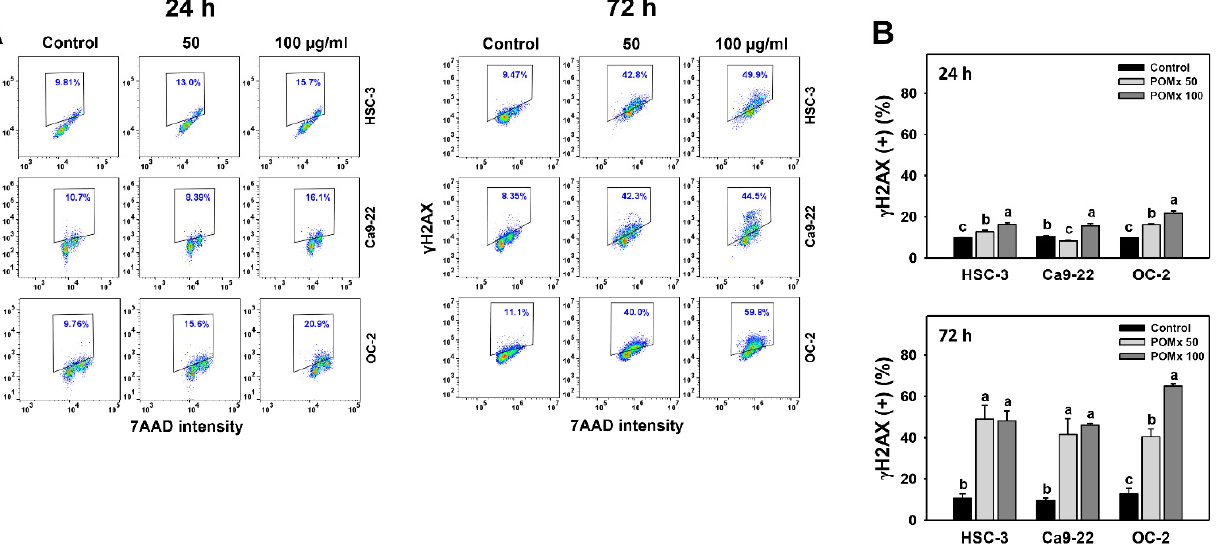
Figure 10. γ H2AX change of oral cancer cells after POMx incubation. ( A ) Dose-response to γ H2AX flow cytometry patterns. Cells (HSC-3, Ca9-22, and OC-2) were incubated with control, 50, and 100 µ g/mL of POMx (control, POMx 50, and POMx 100) for 0, 24, and 72 h. The γ H2AX (+) population (%) is marked within a dashed line. ( B ) Statistics of γ H2AX (+) (%) in ( A ). Treatments without overlapping low cases (a to c) are significantly different for the same cell lines. p < 0.001. Data, mean ± SD ( n = 3).